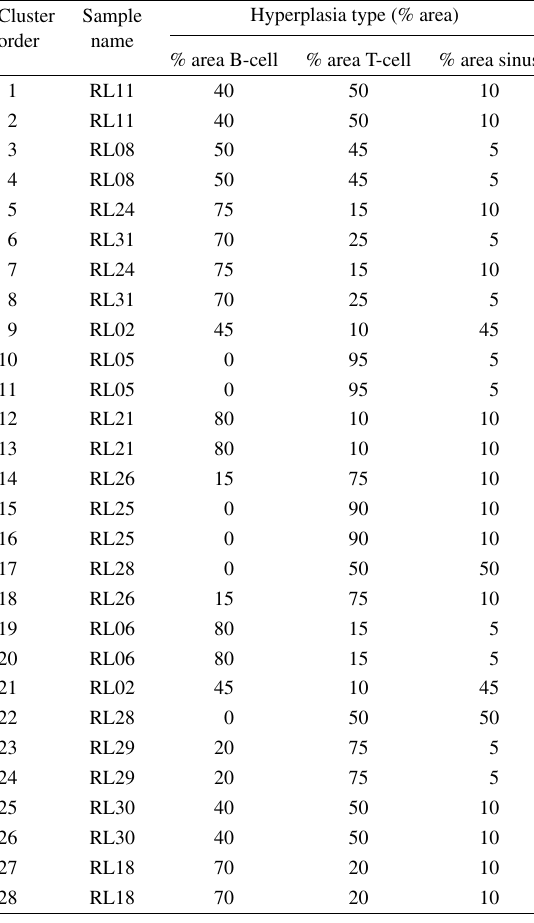
Hyperplasia composition of RL cases in the classification study. Case replicates are listed in the table according to their order in the unsu- pervised clustering with the first case in the list corresponding to the most left one in the image (Fig. 6). The hyperplasia composition was assessed on the adjacent H&E stained sections, and was expressed as the relative area of the whole section Cluster order